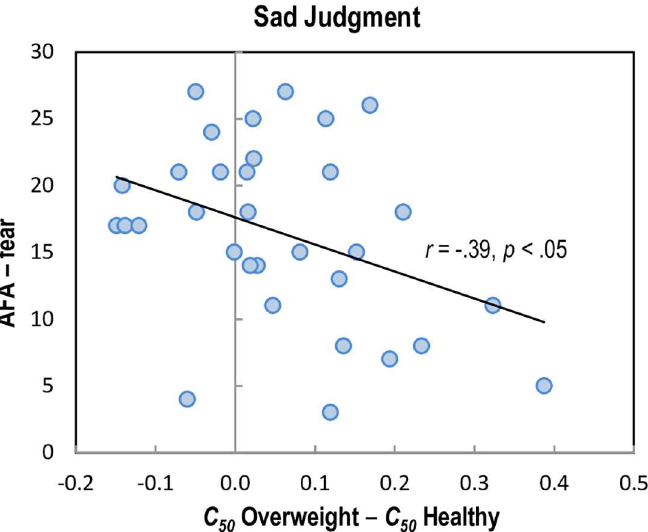
Fig 6. Correlation result. A scatter plot of the relationshipbetweenAFA (Anti-Fat Attitude)–fear scale and C 50 parameter differences ( C 50 Overweight − C 50 Healthy weight) in the neutral-sad judgment task. Higher C 50 difference representslarger bodyweight modulation(the rightward shift of the psychometric curve) on sad decisions.The solid line representsa linear fit.